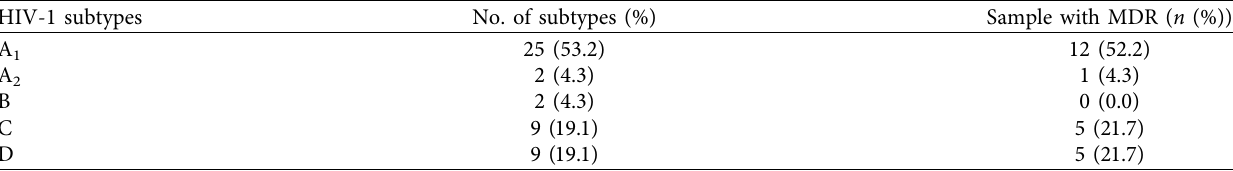
Table 2: Proportion of drug-resistant genotypes.